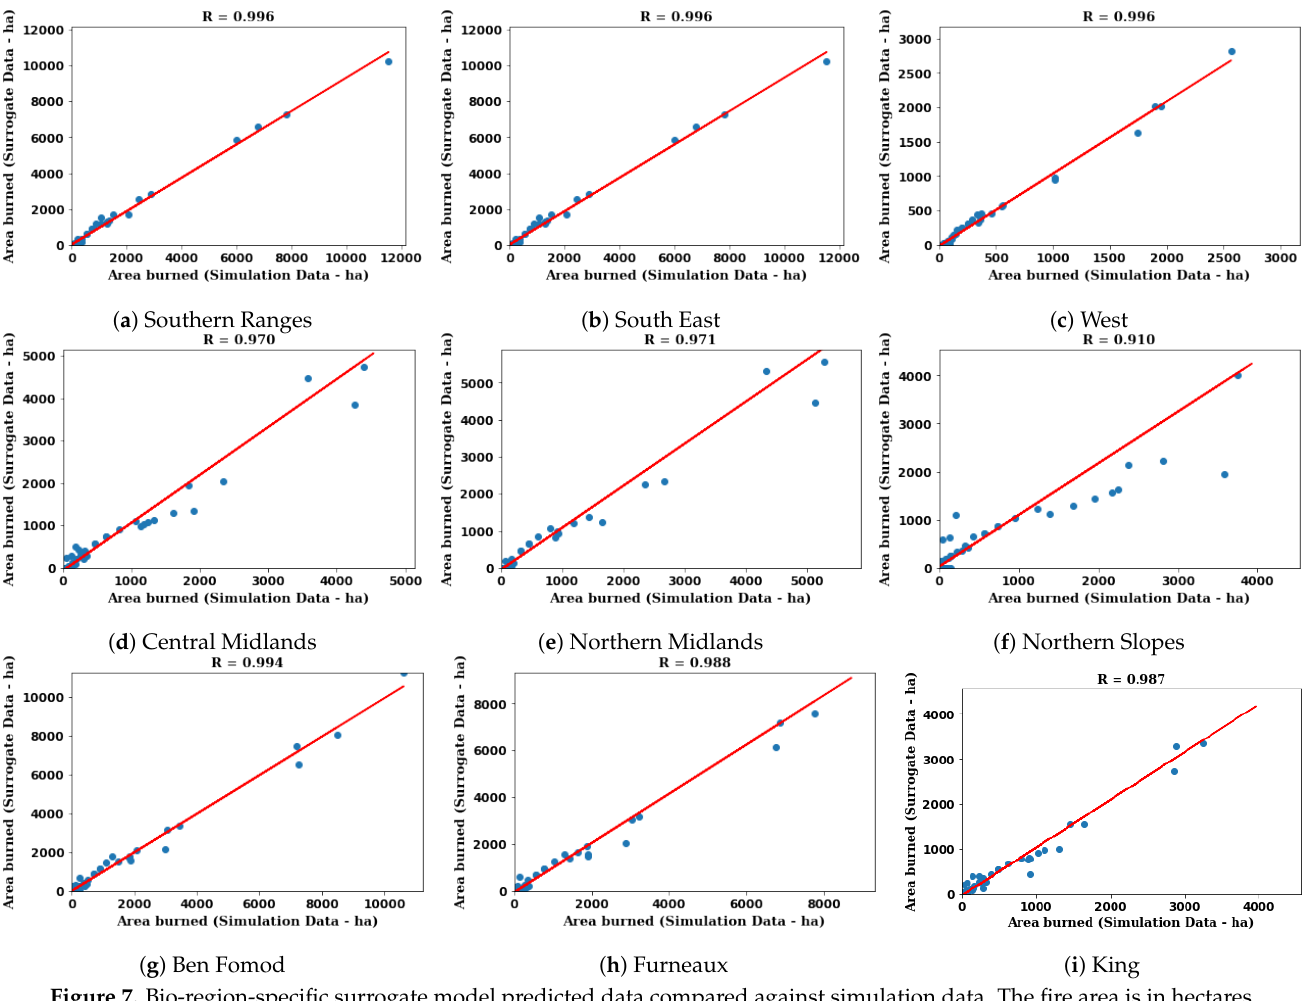
Figure 7. Bio-region-specific surrogate model predicted data compared against simulation data. The fire area is in hectares ( ha ). The red line represents the ideal line where the scatter plots should align for the most accurate surrogate prediction data. The surrogate model constructed for the Southern Ranges bio-region has the highest value of correlation coefficient of 0.996 while that of Northern Slopes is the lowest with a value of